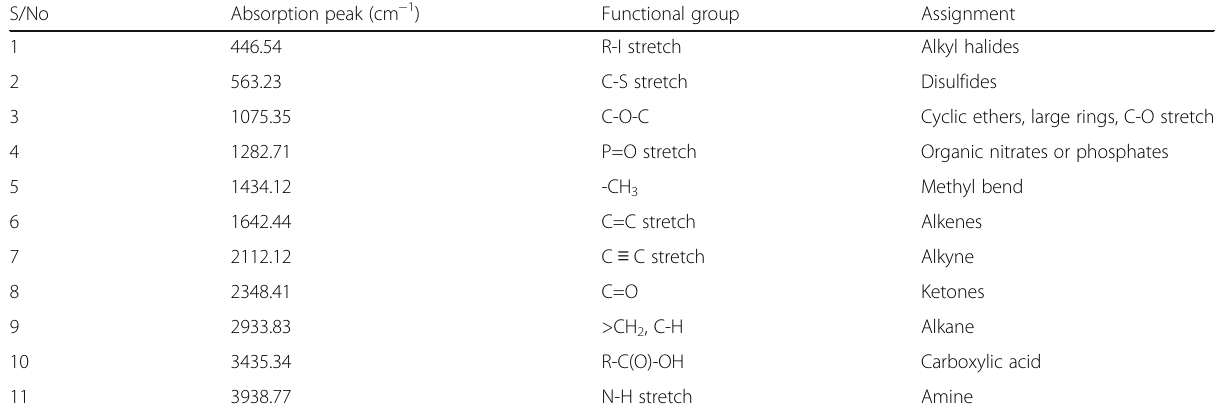
Table 5 Functional Groups Identified by FTIR analysis of F. apodanthera Ethanol Extract S/No